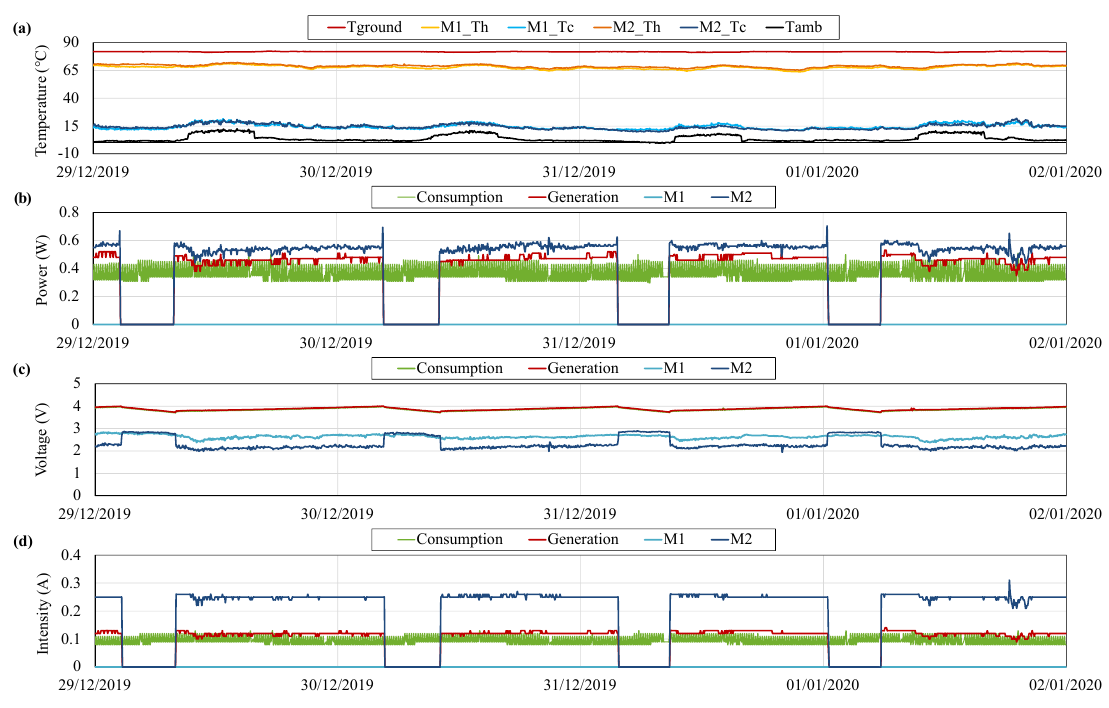
Figure 11. ( a ) Temperature of the ground T ground , the hot and the cold side of two thermoelectric modules M1 and M2 ( T H and T C ) and the ambient T amb , ( b ) power, ( c ) voltage and ( d ) intensity measurements during typical